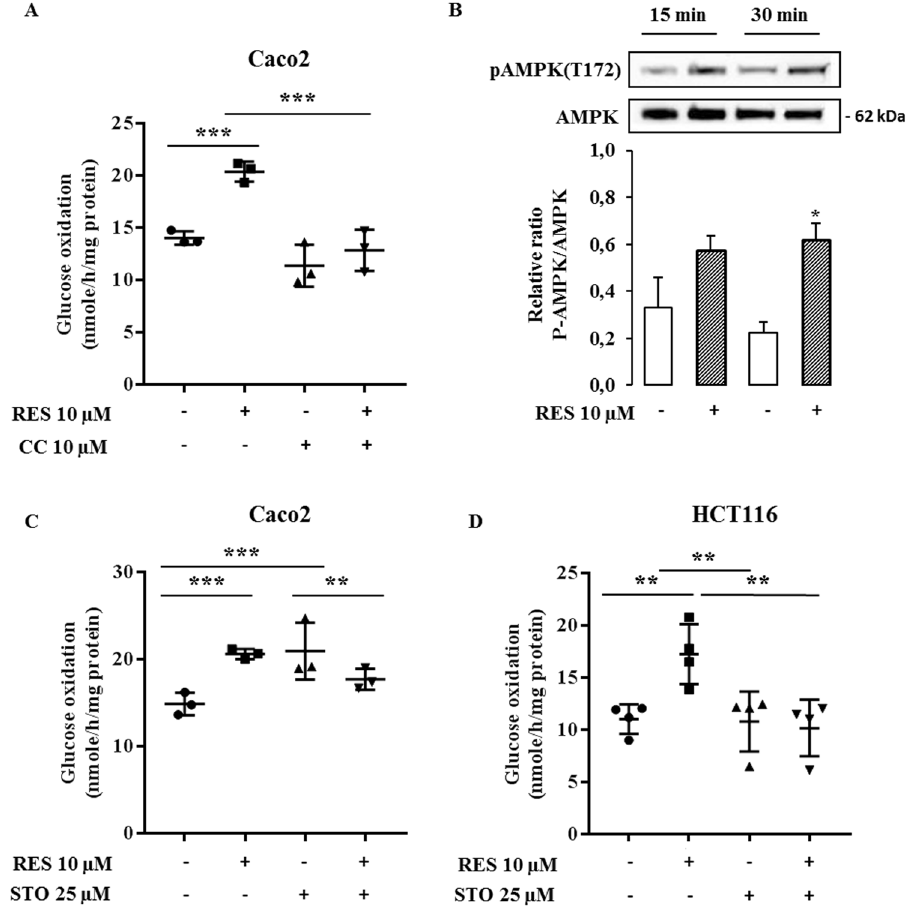
Figure 10. AMPK signaling is involved in resveratrol-induced metabolic shift in colon cancer cells. Subconfluent colon cancer cells were treated with 10 µ M of compound C (CC), an AMPK inhibitor ( A ) or 25 µ M of STO-609 (STO), a CAMKK inhibitor ( C , D ), 1 hour before and during a 48 hour-treatment with 10 µ M resveratrol (RES). Cells were isolated and 10 6 cells were incubated in Krebs-Ringer phosphate buffer supplemented with 5 mM [U 14 C]-glucose (isotopic dilution 1/1000). 14 CO 2 was recovered as described in the Material and Methods section. ( B ) Total cell lysates were collected from Caco2 cells treated with 10 µ M resveratrol for 30 minutes and 1 hour, using RIPA buffer supplemented with protease and phosphatase inhibitors. Lysates were analyzed by Western blot using antibodies against P-AMPK(T172) and AMPK. Results are the means ± SEM of at least 3 independent experiments each performed in triplicate ( * p < 0.05, ** p < 0.01, *** p < 0.001 vs